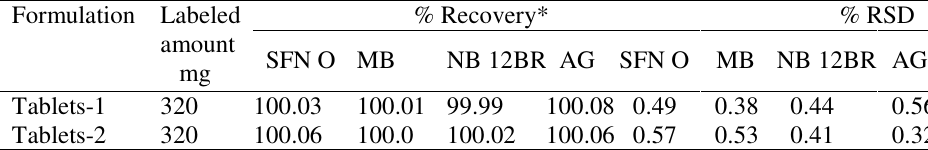
Table 4. Results of analysis of tablet formulations containing GFX